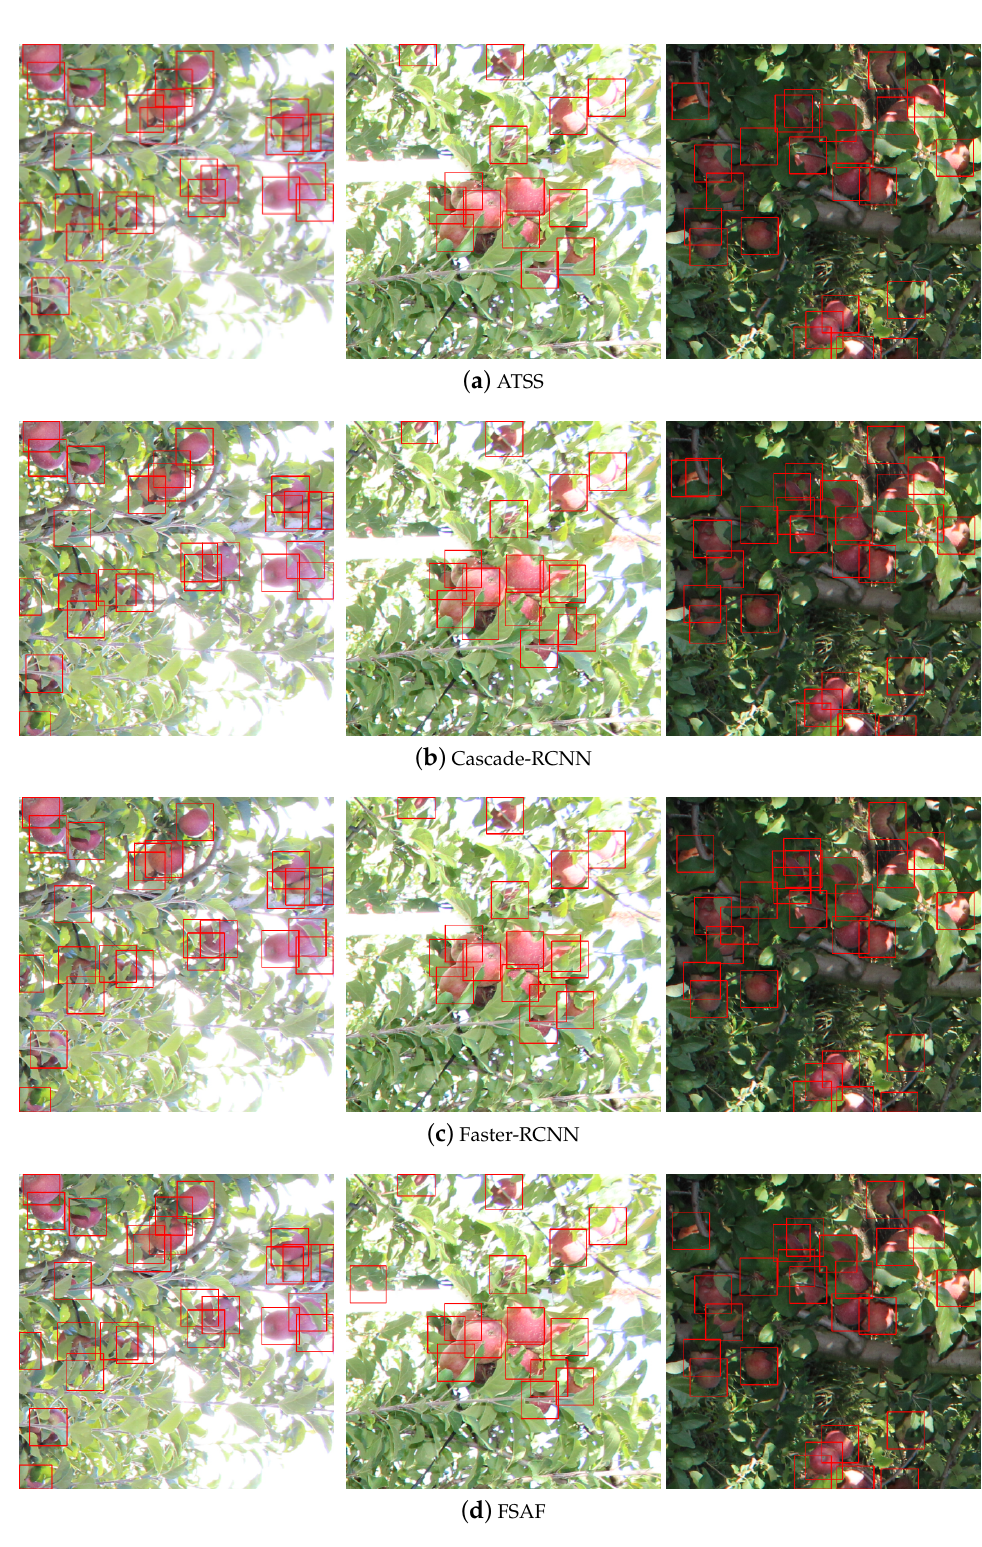
Figure 7. Examples of apple detection using ( a ) Adaptative Training Sample Selection (ATSS), ( b ) Cascade-Regions with Convolutional Neural Network (Cascade-RCNN), ( c ) Faster-Regions with Convolutional Neural Network (Faster-RCNN) , and ( d ) Feature Selective Anchor-Free